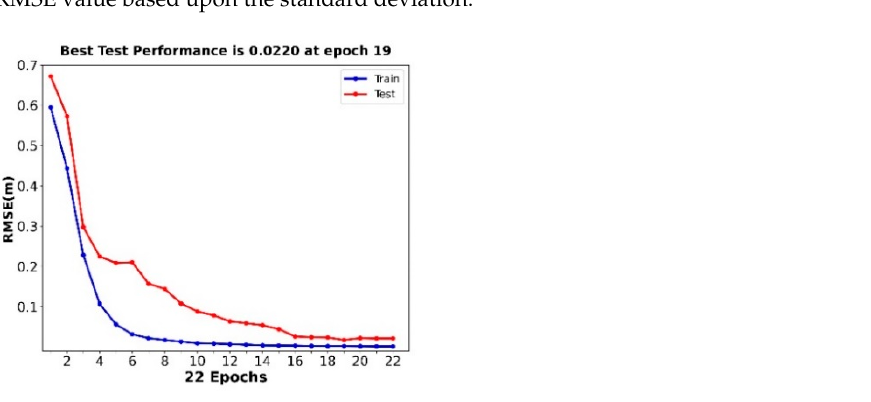
Figure 4. The performance of the ANN model when using the multisource observation datasets in January 2019.